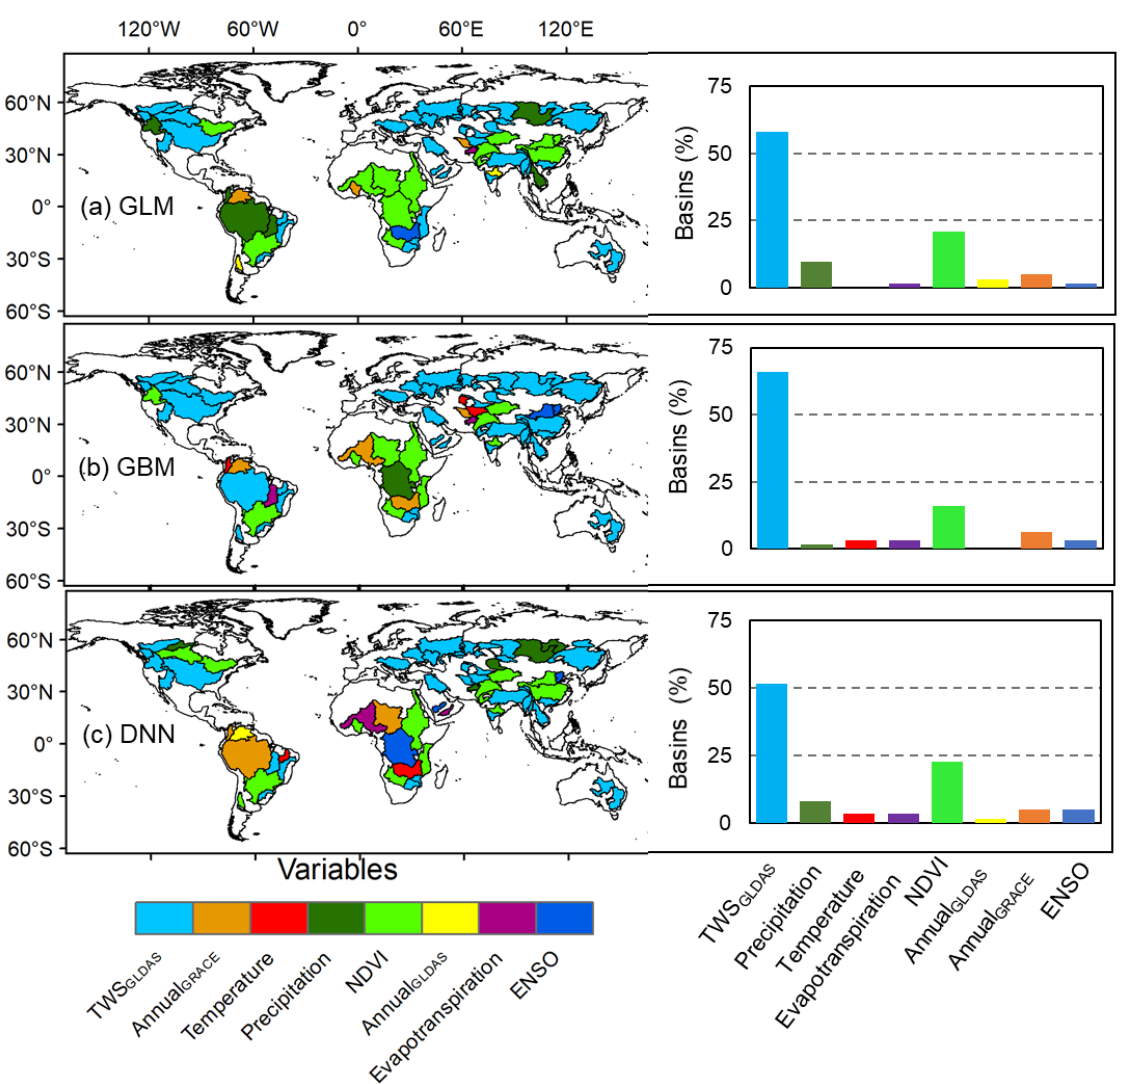
Figure 8. Spatial ( left ) and frequency ( right ) distribution of the basin-scale variable importance for ( a ) GLM, ( b ) GBM, and ( c ) DNN